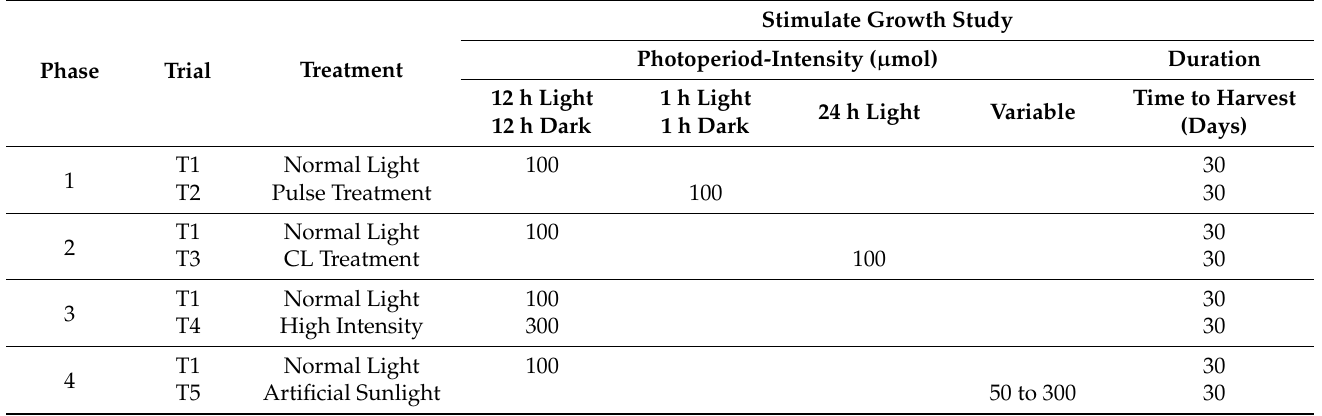
Table 3. The parameters for simulating growth experiment (part